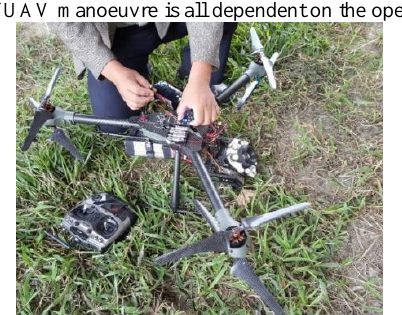
Figure 3. The appearance of the used UAV